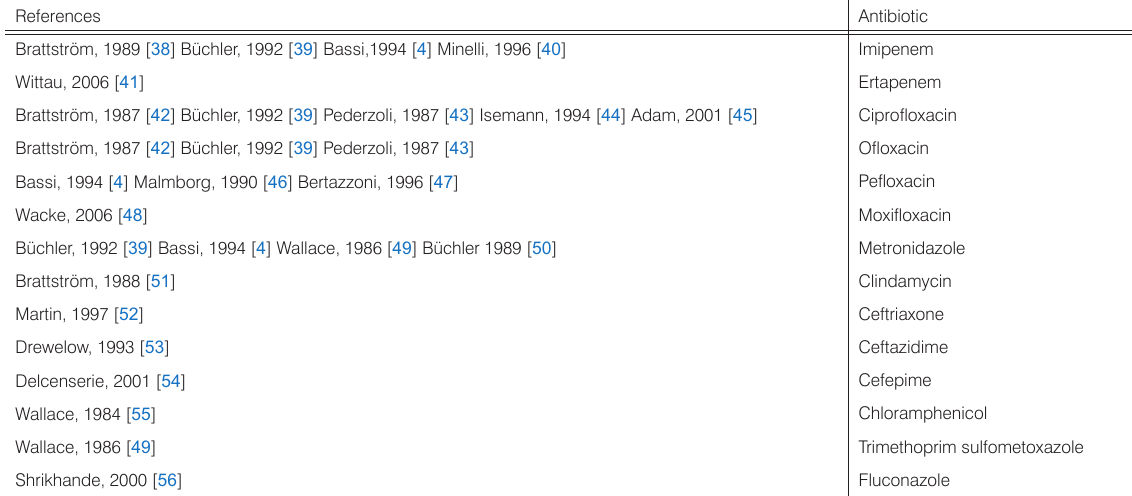
Table 5. Adequate antibiotic pancreatic tissue and fluid